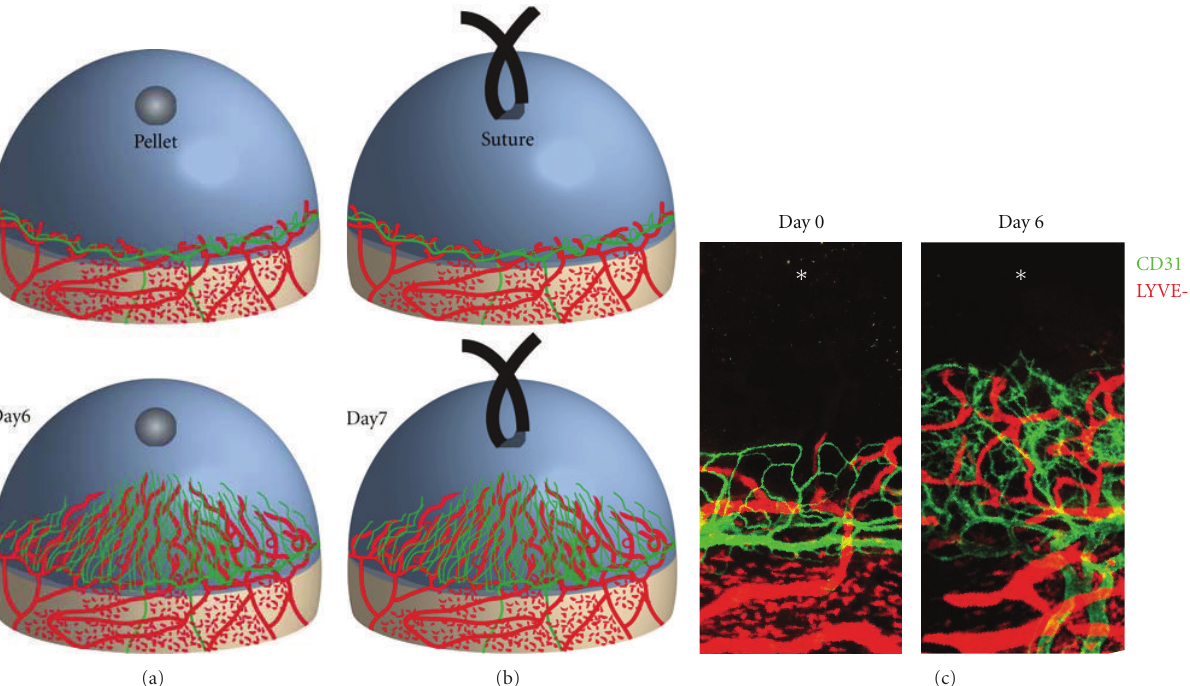
Figure 2: Mouse cornea lymphangiogenesis model. No lymphatic vessels exist in the normal mammalian cornea. Implantation of growth factor or cytokine into a surgically created micropocket in the mouse cornea stroma (a) or corneal injury by suture (b) induces lymphan- giogenic response. Corneal lymphangiogenesis as well as angiogenesis can be examined 6 or 7 days after pellet implantation or suture, respectively (a) and (b). Double staining of corneal flat mounts for lymphangiogenic (LYVE-1, red) endothelium and angiogenic (CD31, green) with immunohistochemistry